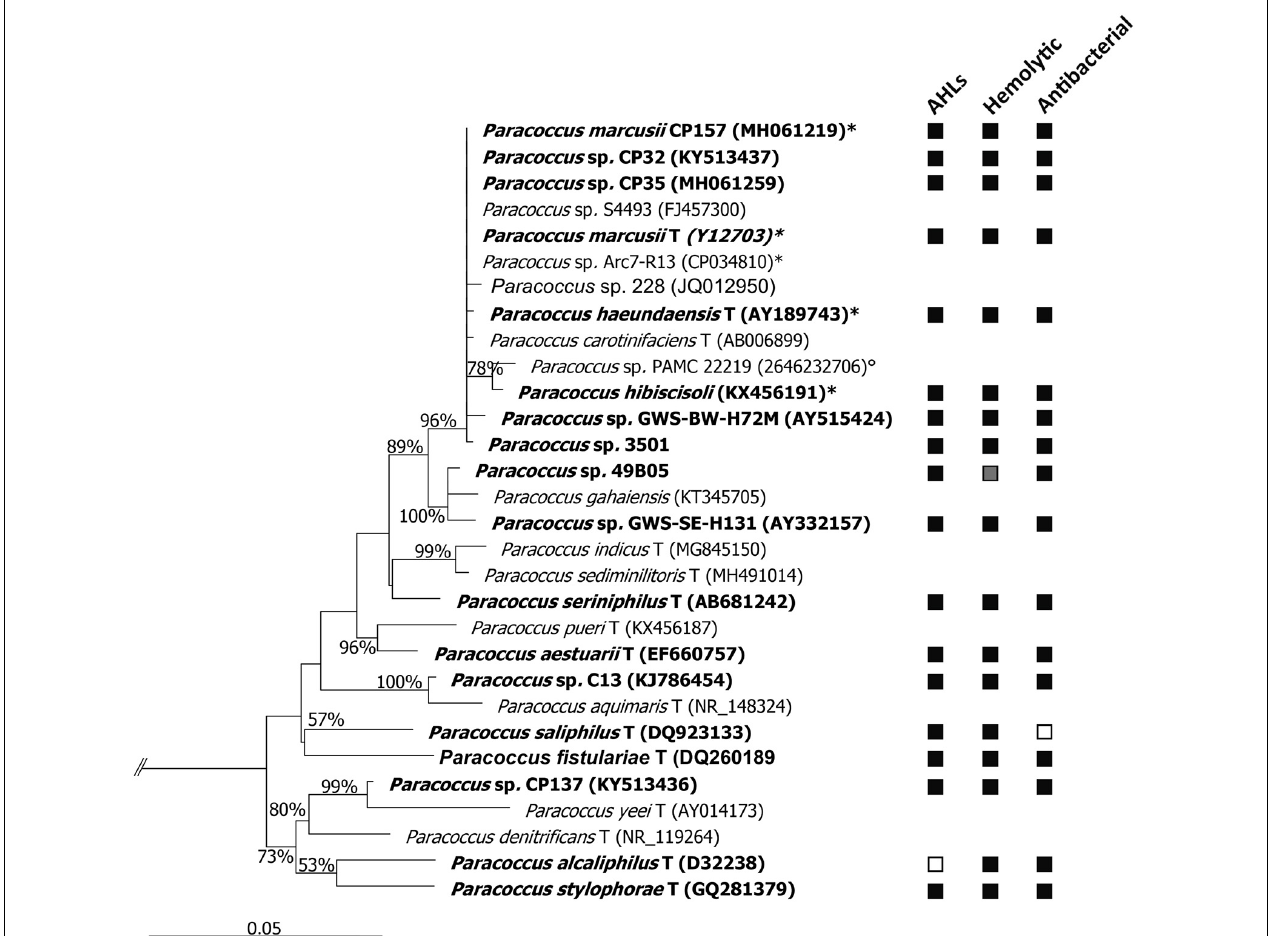
FIGURE 1 | Neighbor-joining tree based on 16S rRNA gene sequence similarity, showing the phylogenetic affiliation of all Paracoccus spp. analyzed in this study (in bold). Positive ( (cid:4) ) or negative ( (cid:3) ) results for secondary metabolites screenings are given behind the respective strain. Paracoccus sp. 49B05 did not grow on blood agar plates, hence no result ( (cid:4) ) could be recorded. The tree was calculated with sequences ≥ 1,250 bp. Only bootstrap values ≥ 50% (derived from 1,000 replicates) at main nodes are shown. Selected sequences related to Enterobacteriaceae (AB242910, HG972968, HQ122932, and KF516242) were used as outgroup to define the root of the tree. Root not shown (cut at//). GenBank accession numbers are given in parentheses. ∗ Strains subjected to in silico DDH, ◦ 16S rRNA gene sequence obtained from JGI (https://img.jgi.doe.gov/), T type strain of species. TABLE 1 | Biosynthesis gene clusters (BSGCs) detected in the genome of Paracoccus marcusii CP157 by antiSMASH 5.2 run in strict mode. Element Locus (from) Locus (to) Size (kbp) Predicted BSGC type Most similar known BSGC